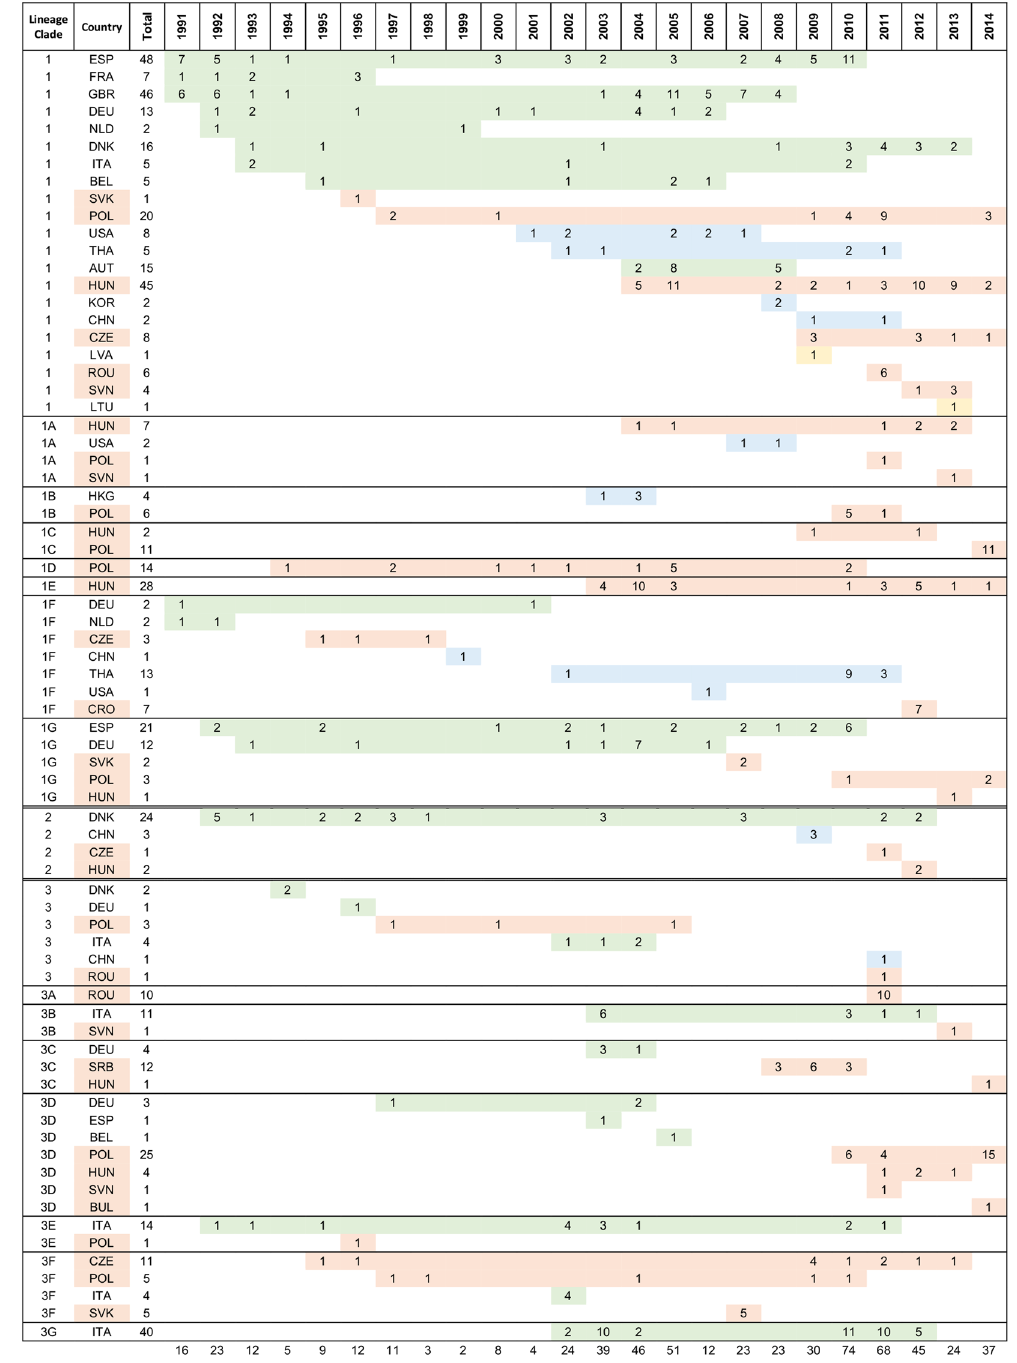
Figure 1. Summary results of phylogenetic analysis (green – Western European countries, orange – CEE countries, blue – outside of Europe, yellow – EE